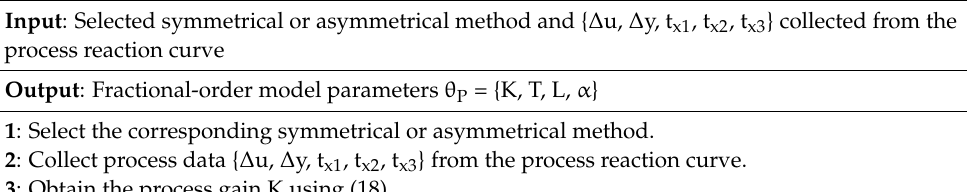
Algorithm 1. Three-Point Identification Method for FFOPDT